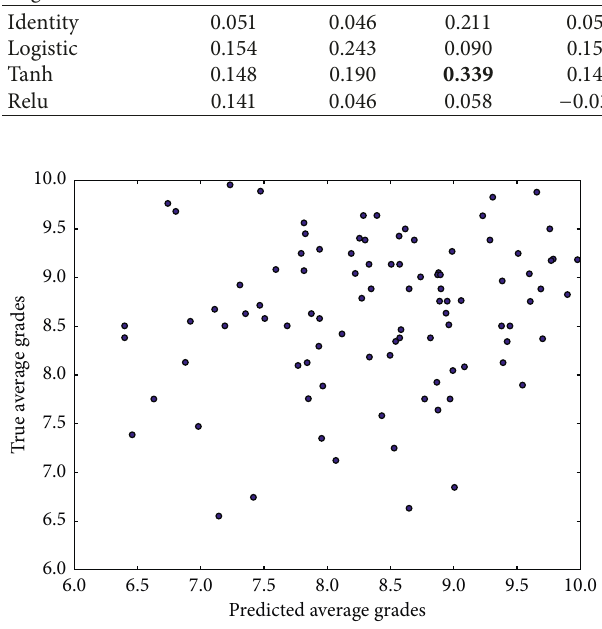
Figure 4: The true and predicted average grades with